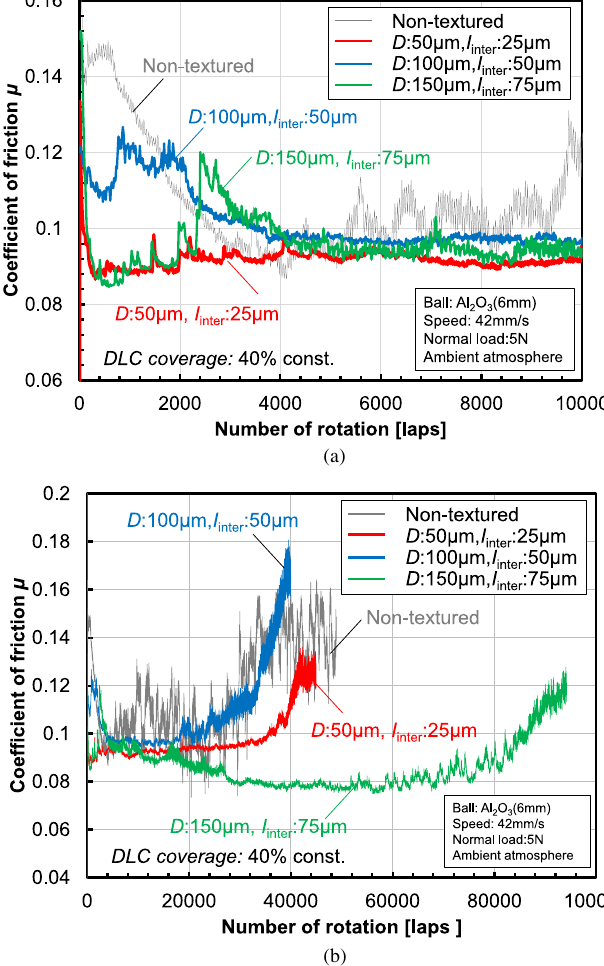
Fig. 14. Evolution of COF during (a) initial 10 000 laps and (b) until 100 000 laps of ball-on-disk friction test of non-textured and micro-textured DLC fi lms with different texture